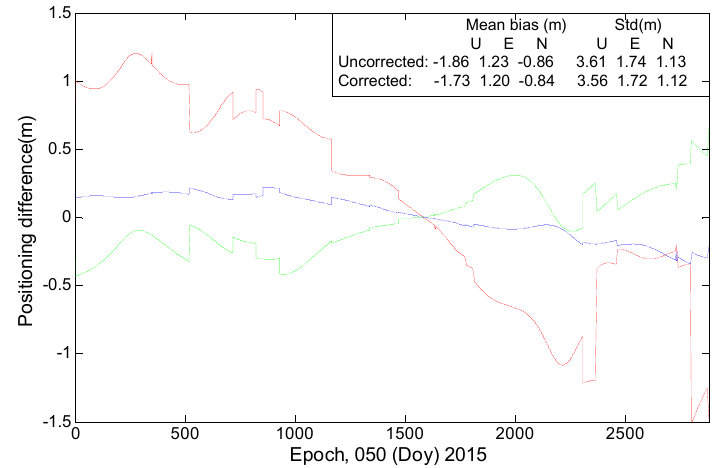
Figure 17. “Positioning difference” is the difference between SPP estimations with and without employing the correction model. The “mean bias” represents the equal result of the positioning errors. “Uncorrected” indicates the results when the code bias is not corrected; “Corrected” indicates the results after the model has been applied.